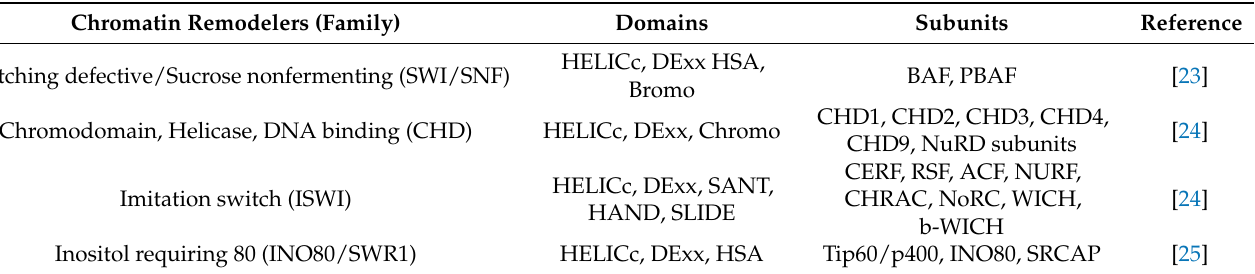
Table 1. List of four major chromatin remodeller family and their structural